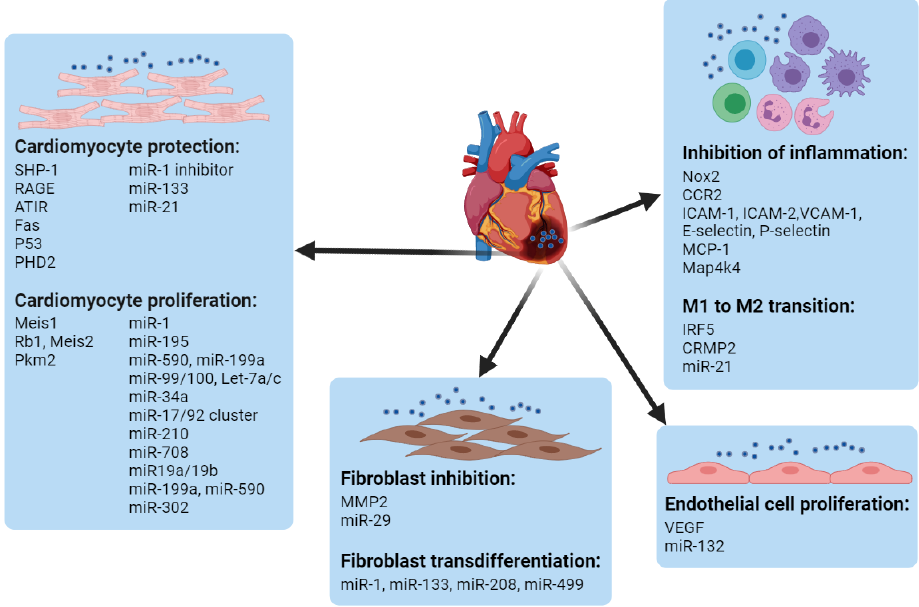
Figure 3. Genes or miRNAs in different cardiac cells that have been utilized as therapeutic targets in non-viral delivery systems for cardiac repair/regeneration.